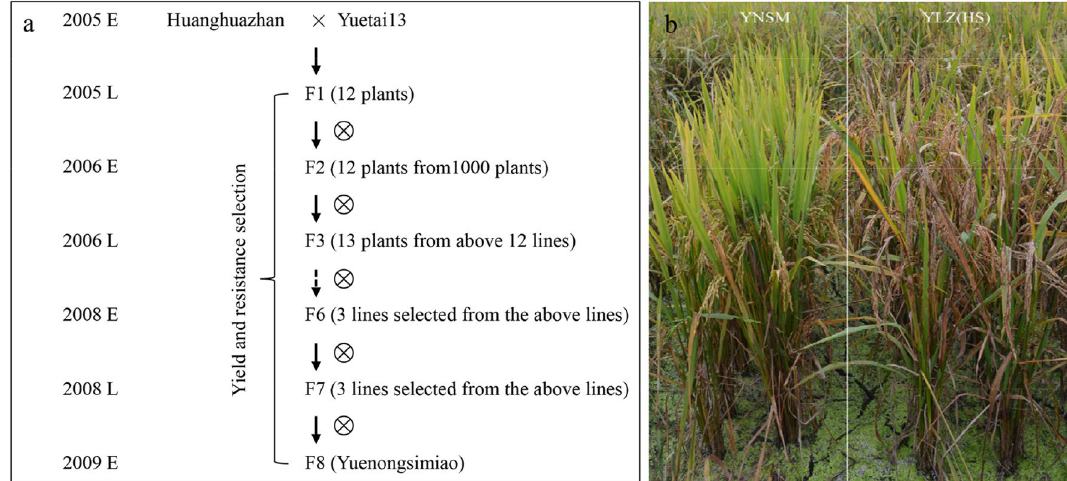
Figure 1. Flowchart and the blast resistance for the development of YNSM. ( a ), Flowchart for the development of YNSM; ( b ), The high blast resistance of YNSM. Yueluzhan (YLZ), a high susceptible (HS) variety to Magnaporthe oryzae in the diseased area in Conghua,